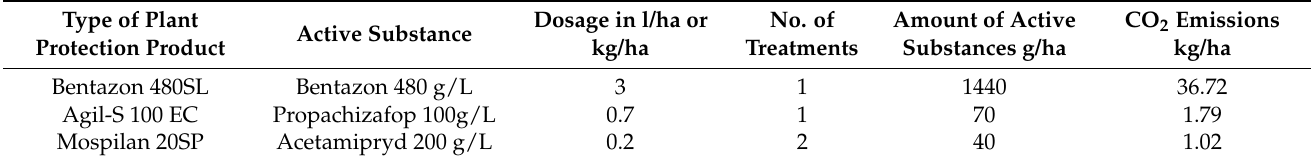
Table 6. Plant protection products used in the cultivation of